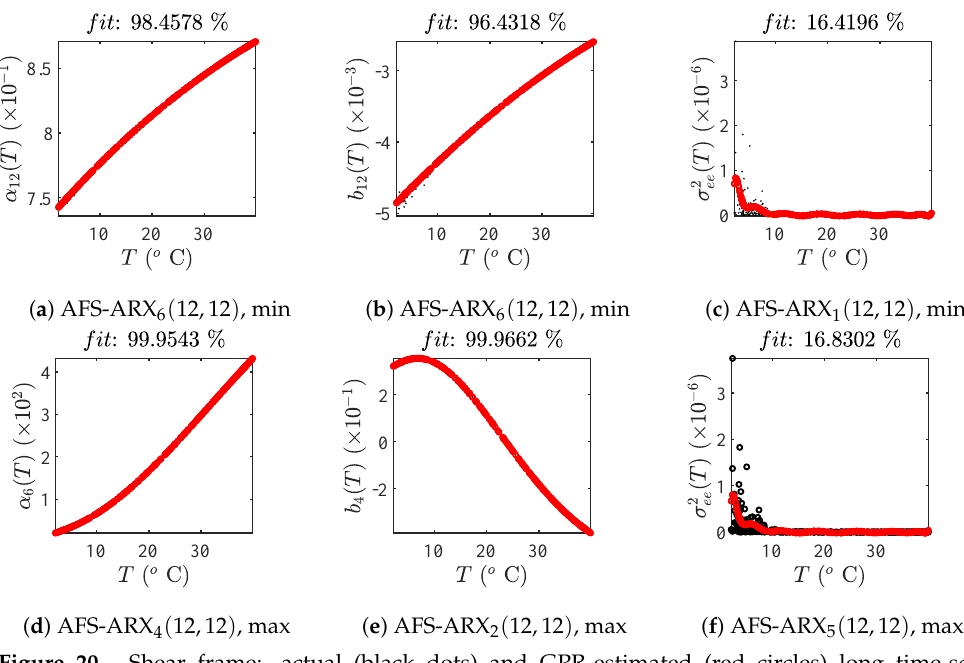
Figure 20. Shear frame: actual (black dots) and GPR-estimated (red circles) long time-scale parameter evolution.